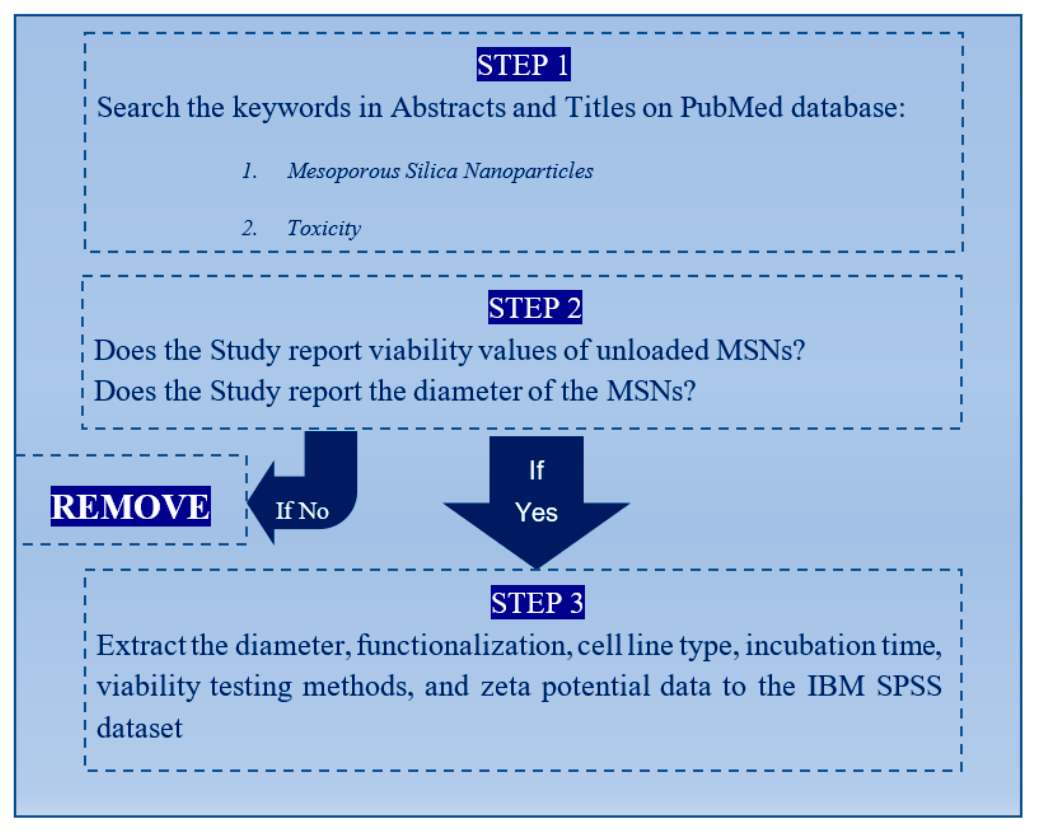
Figure 1. Schematic representation of the study selection procedure. This shows the flow chart of the paper selection process. paper selection